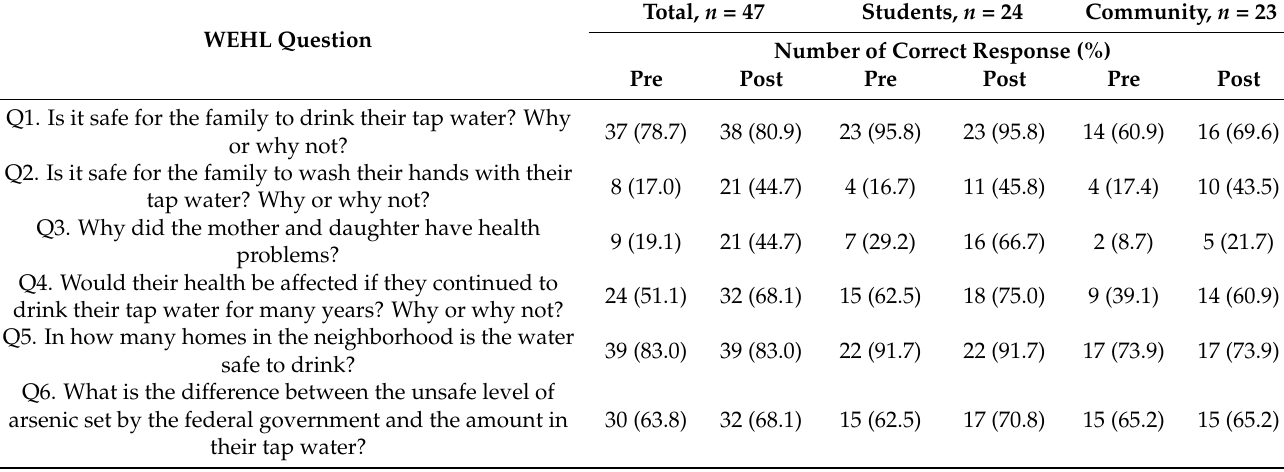
Table 4. Correct responses to environmental health knowledge